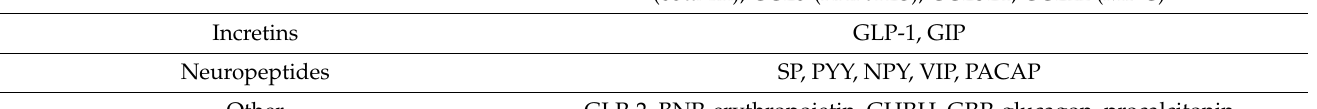
Table 1. Examples of bioactive peptides and proteins cleaved by DPP-IV [2–6]. Chemokines